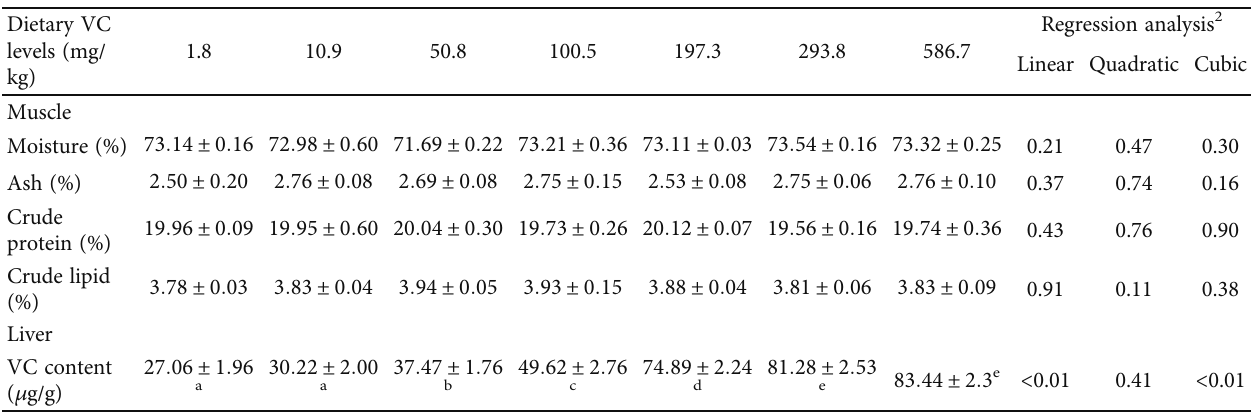
Figure 1: Cubic regression analysis of SGR with dietary vitamin C (VC) levels in coho salmon Oncorhynchus kisutch (Walbaum, 1792) postsmolts. The predicted dietary VC requirements of SGR and FCR are 188.10 and 190.68mg/kg, respectively. Abbreviation: SGR: speci fi c growth rate; FCR: feed conversion ratio. Table 3: Muscle proximate composition and liver vitamin C (VC) concentrations of coho salmon Oncorhynchus kisutch (Walbaum, 1792) postsmolts fed the experimental diets with graded VC levels after 10 weeks 1